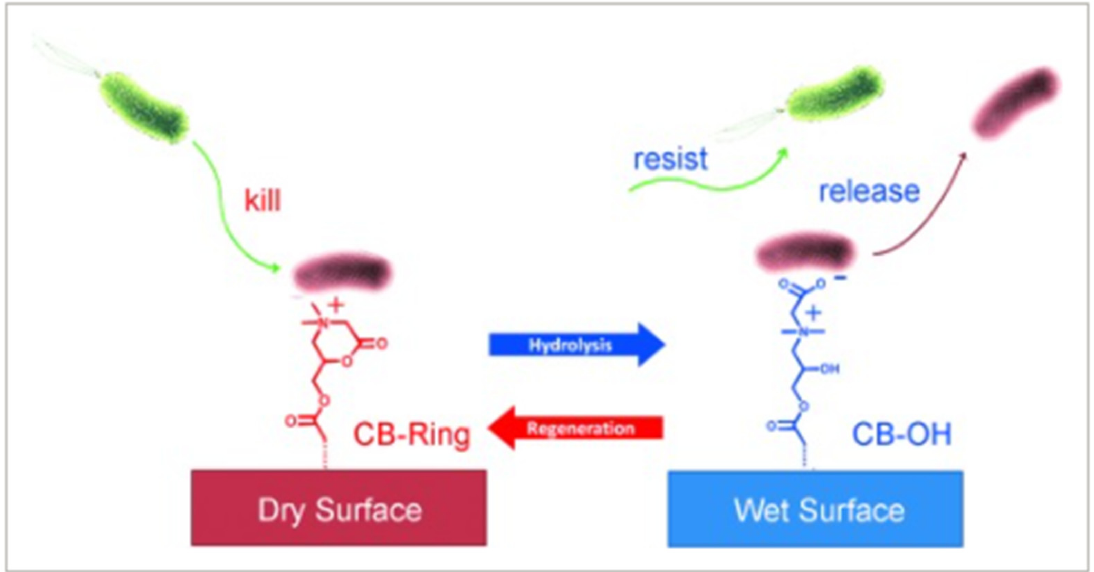
Figure 17. A smart polymer coating repeatedly switches between the attacking function (cationic ring (CB-ring), to kill bacteria under dry conditions) and defending function (zwitterionic carboxy betaine (CB-OH), to release and resist bacteria under wet conditions). CB-Ring can be hydrolyzed to CB-OH in neutral or basic aqueous solutions and can be regenerated by dipping CB-OH in acidic media. Reprinted with permission from ref. [203]. Copyright 2012 Wiley.